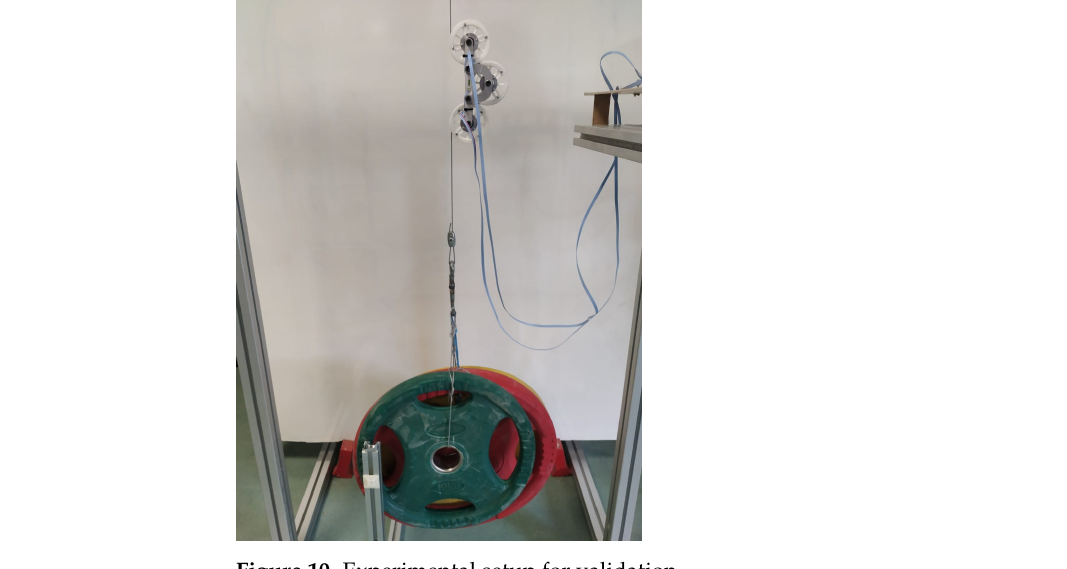
Figure 10. Experimental setup for validation. Table 1. Weights employed for device validation and calibration.